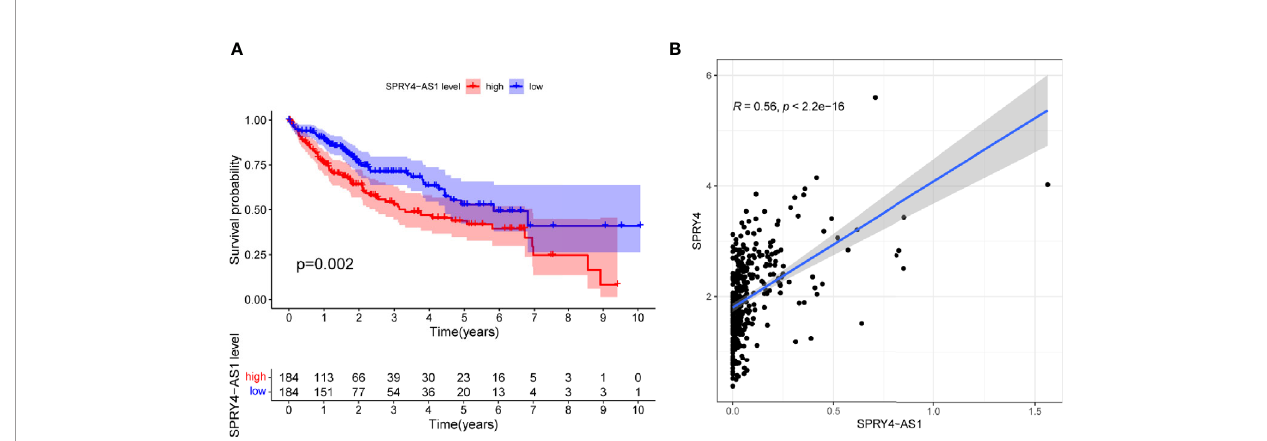
FIGURE 1 | (A) Kaplan – Meier survival analysis of hepatocellular carcinoma (HCC) patients ’ overall survival based on SPRY4 antisense RNA 1 (SPRY4-AS1) expression in The Cancer Genome Atlas (TCGA) datasets. (B) The correlation between SPRY4-AS1 and SPRY4 expression analyzed in TGCA